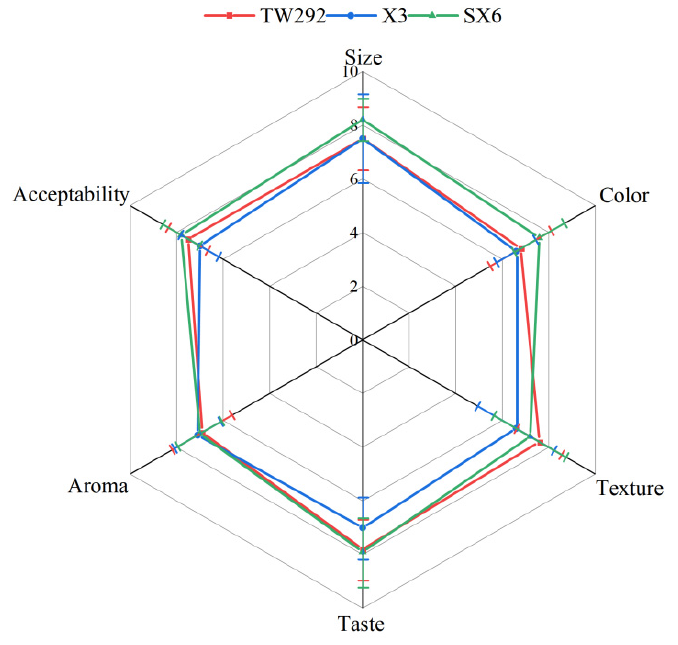
Figure 2. Radar map for sensory evaluation of three vegetable soybeans.